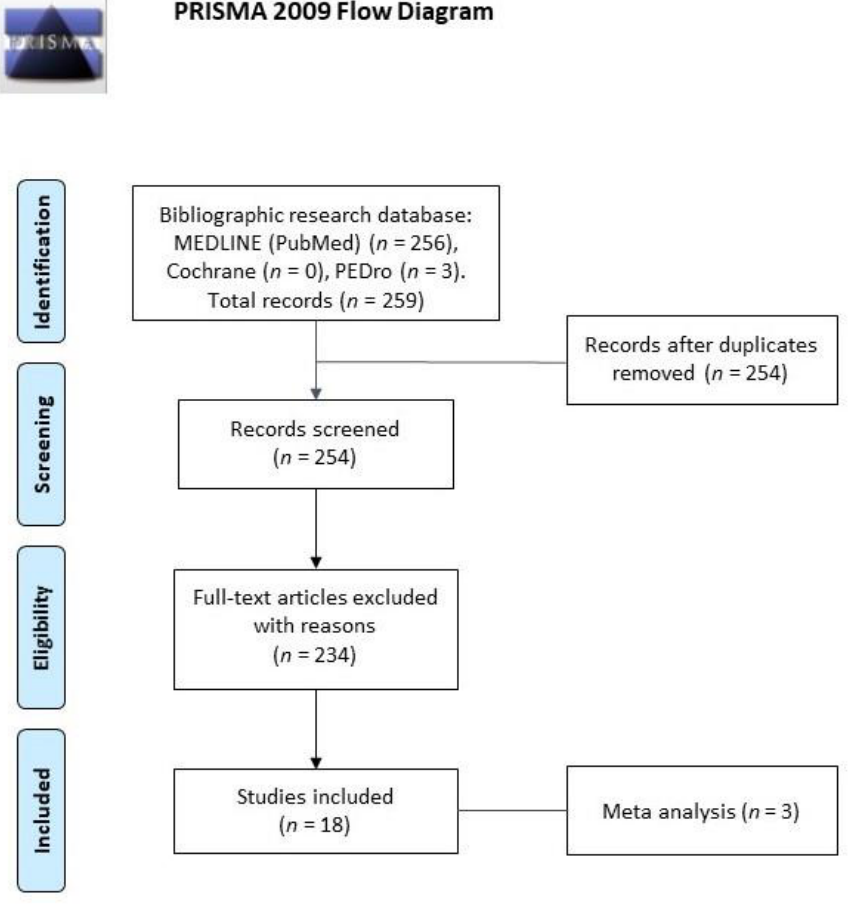
Figure 1. Prisma flow diagram.